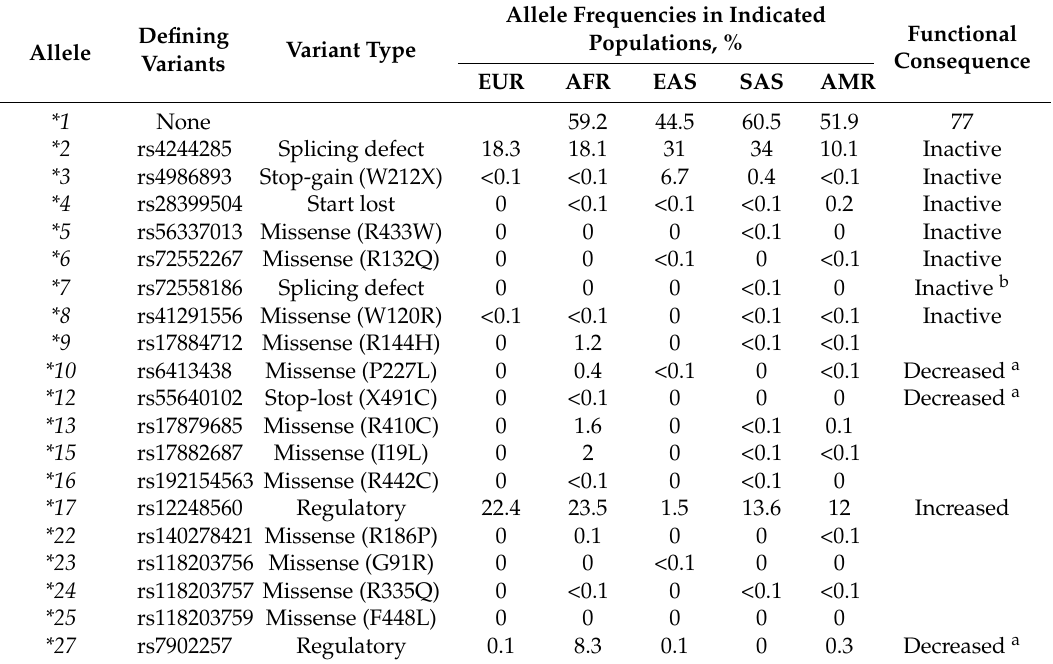
Table 3. Variant and allele frequencies in the human CYP2C19 family among various